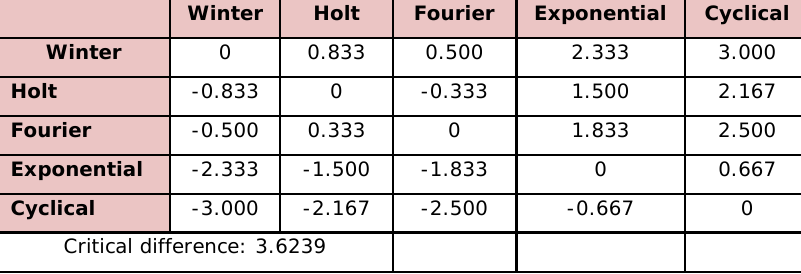
Table 4. “Pair wise differences for inventory results”